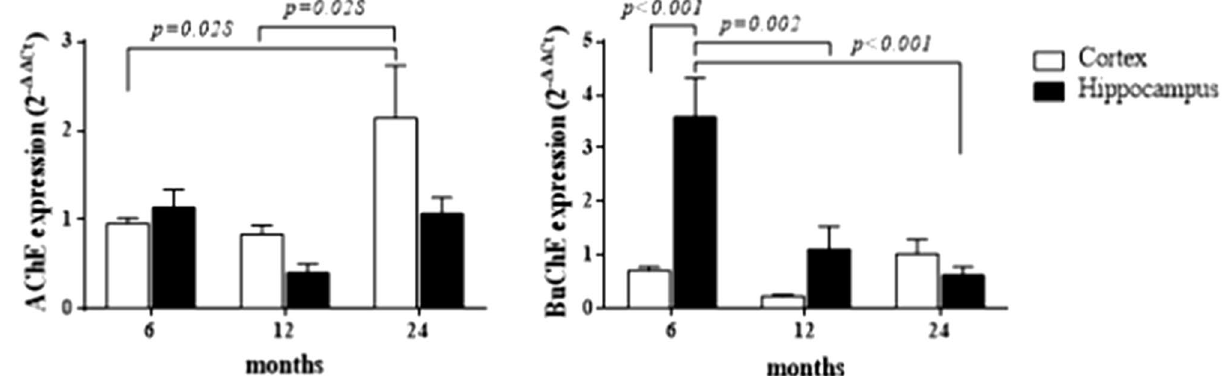
Figure 8. Cholinesterase enzymes expression levels in cortex and hippocampus at different postnatal ages. Bar plots graphically depict the mean and SEM of AChE and BuChE gene expression levels in cortex and hippocampus at different postnatal ages, in comparison to WT mice. Statistically significant p-values, after adjustment according to the FDR methods, are graphically depicted